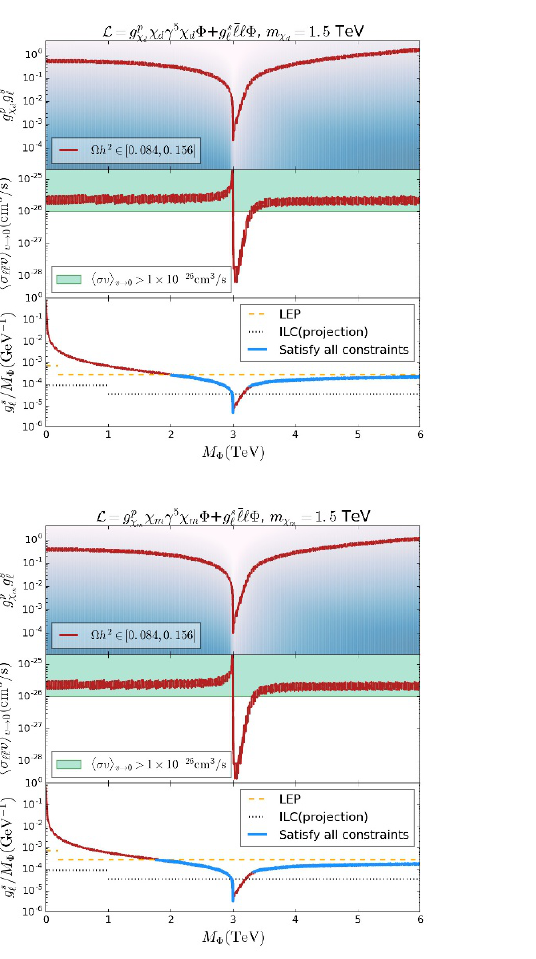
Figure 2 . A scalar mediator pseudoscalar coupled to Dirac fermion DM (top) and Majorana fermion DM (bottom). The mediator coupling with leptons is scalar (left) or pseudoscalar (right). Each panel shows DM properties as a function of mediator mass. The blue color gradient in the (cid:12)rst panel shows relic density, where darker blue means greater relic